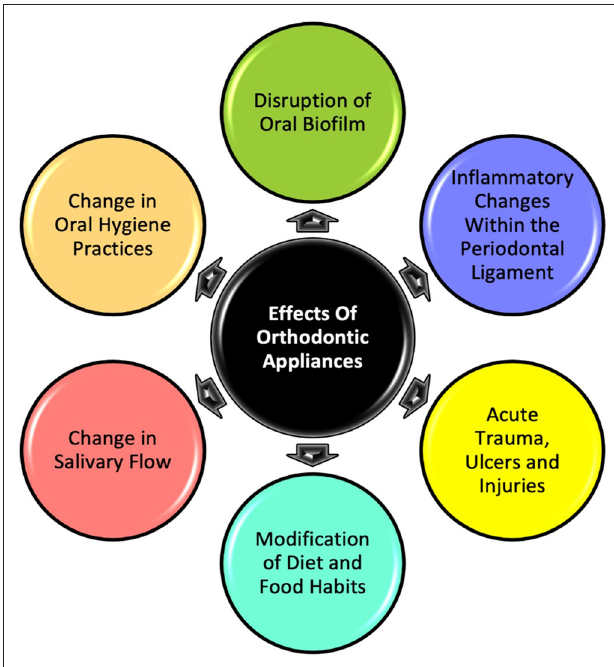
FIGURE 1 | Impact of orthodontic appliances on intra-oral